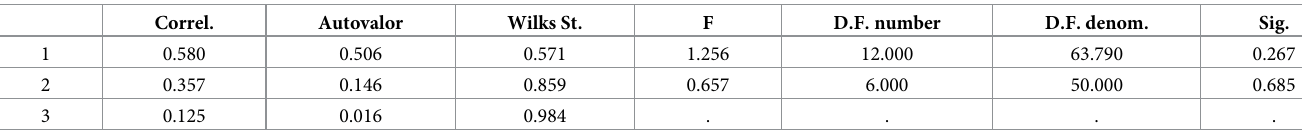
The canonical roots are the squared CCs, which provide an estimate of the amount of shared variance among the respective optimally weighted canonical variates. It is considered acceptable when it passes 10%. In this case, it had a value of 45.8% (0.677 2 ). The redundancy index is the amount of variance in one set of variables. It is explained by